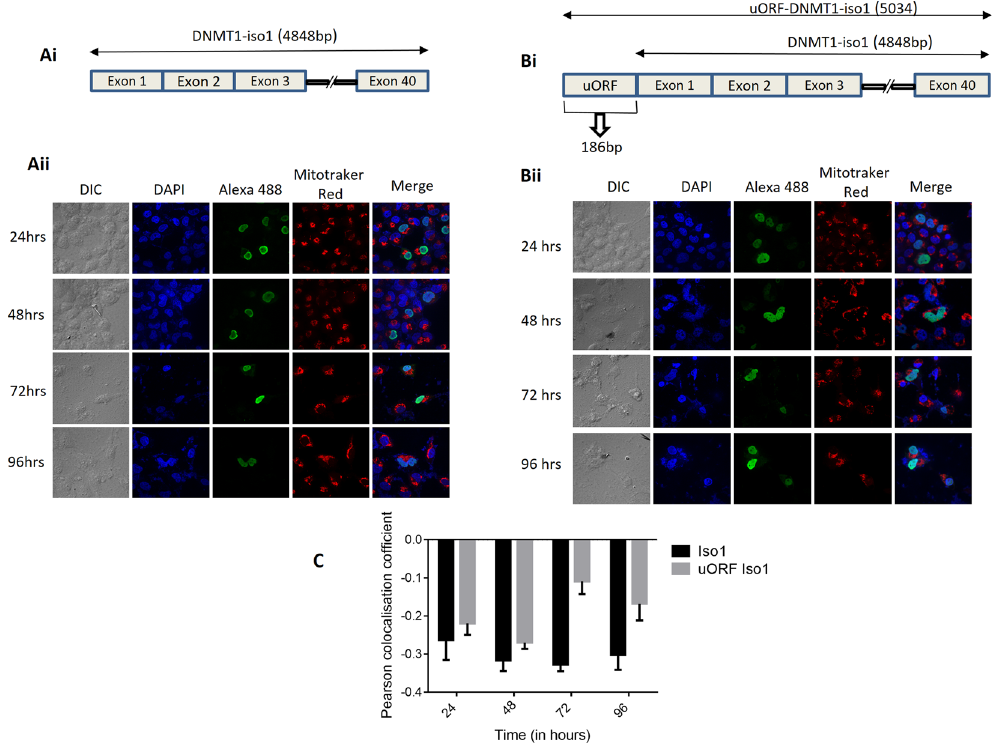
Figure 2. DNMT1-isoform1 fails to localize in mitochondria and exclusively localizes to the nucleus at all the analyzed time points. ( Ai-Bi ) Schematic diagram depicting the structure of: ( Ai ) DNMT1-iso1; ( Bi ) DNMT1- iso1 with uORF. ( Aii-Bii ) Representative confocal images of H1299 cells showing localization pattern of exogenously overexpressed: ( Aii ) DNMT1-isoform1 and ( Bii ) DNMT1-iso1 with uORF at four different time points (24, 48, 72, 96 hrs). ( C ) Pearson co-localization coefficient for mitochondrial localization of DNMT1-iso1 and DNMT1-iso1 with